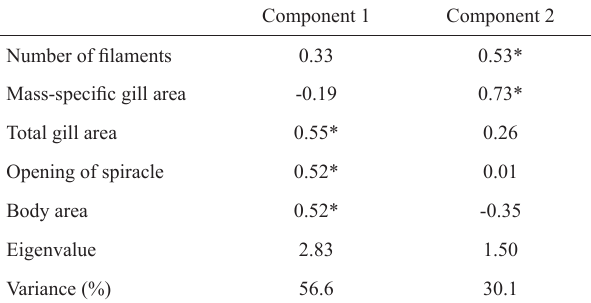
Table 6. The two main morphological principal component axes and the loading per morphological character. Highest loadings are highlighted in asterisk. The eigenvalues and percentages of explainable variance on the first two PCA axes are listed